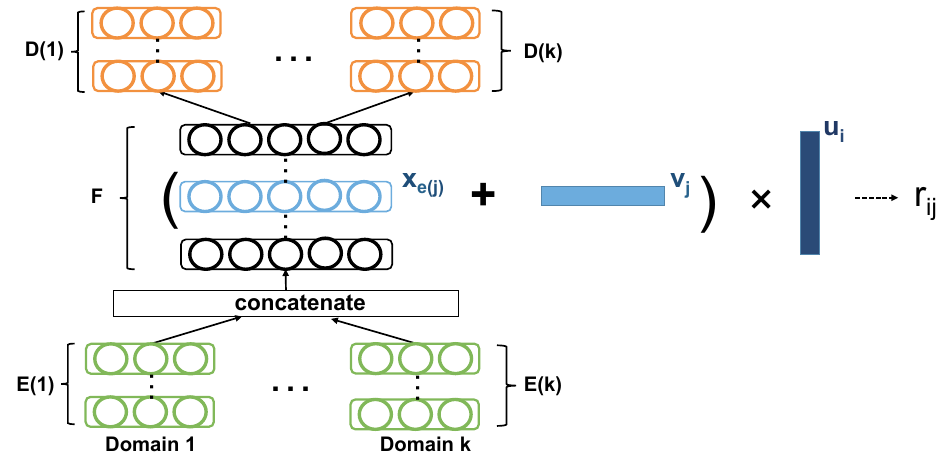
Figure 1. Rating prediction with deep fused